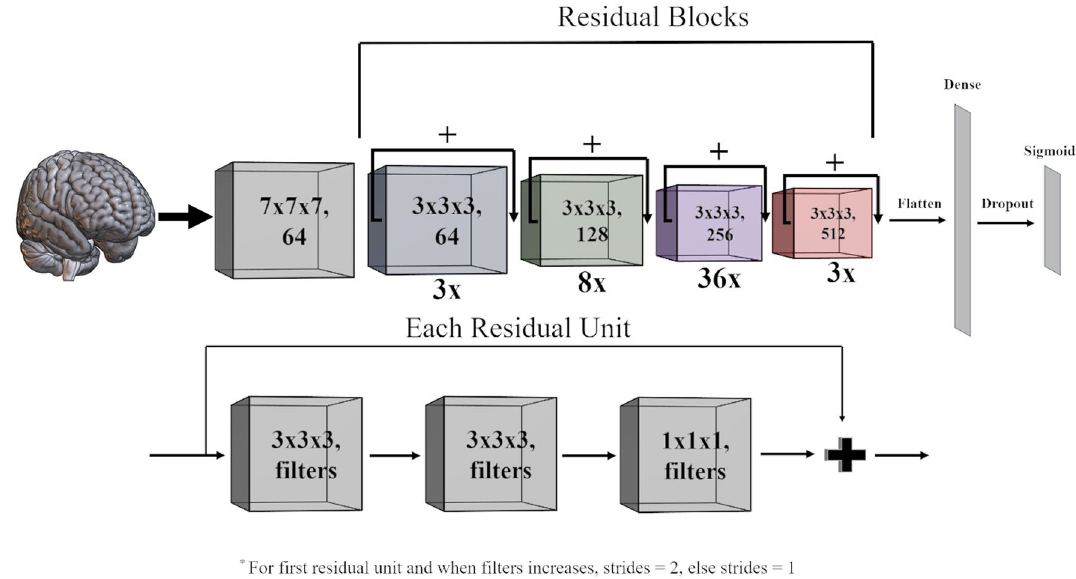
Figure 4. Schematic of the 3D-ResNet-152 that was used for this analysis. Each image was first passed through a 3D convolutional layer (7 × 7 × 7, 64 filters) with ReLu activation and batch normalization, followed by a series of 50 residual units, each with 3 convolutional layers (bottom panel). This output was relayed to a fully- connected dense layer with one output and sigmoid activation (top